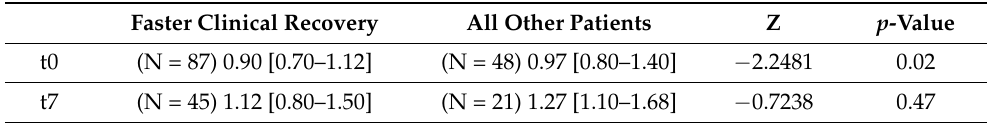
Table 4. Comparison of plasma CGRP levels (ng/mL) at baseline (t0) and after 7 (t7) days of hospitalization between patients with a faster recovery (discharge and/or NEWS2 ≤ 2 for at least 24 h within 14 days of hospitalization) vs. all other patients. Values are expressed as median (IQR). Bold text highlights the statistically significant results. N = number of analyzed patients.